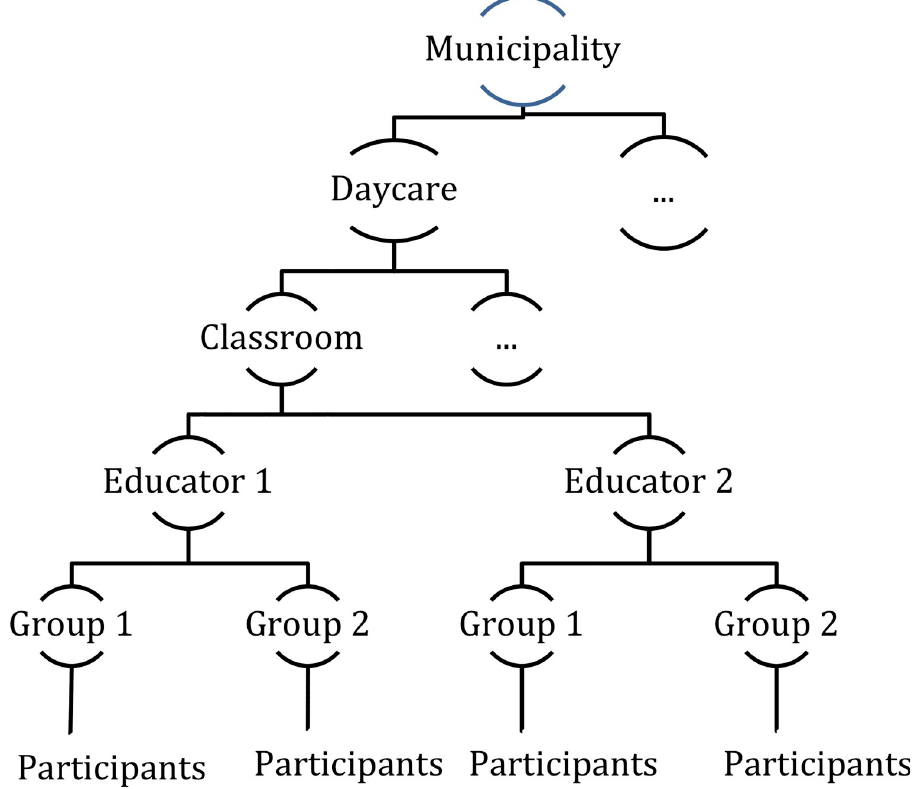
Fig 1. The hierarchical structure of the analyzed data